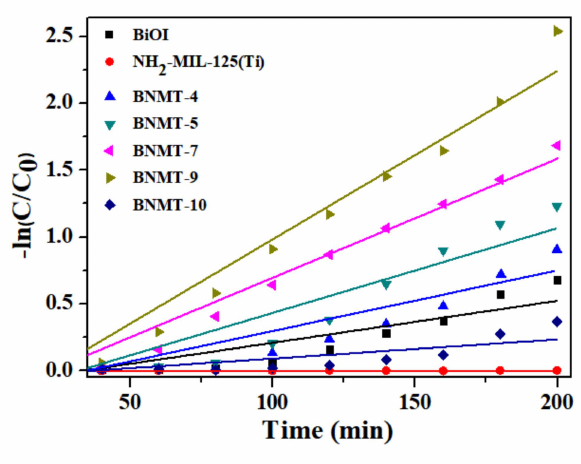
Figure 9. The pseudo-first-order reaction kinetics of the as-prepared samples of the degradation of